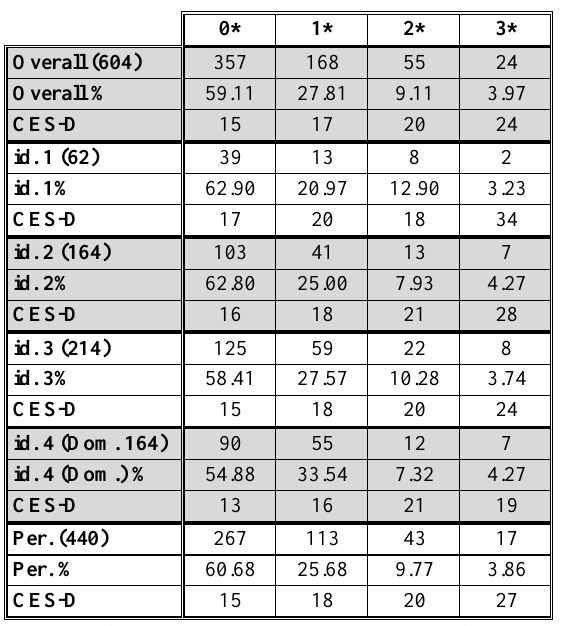
Table 9 : CES-D based on declared